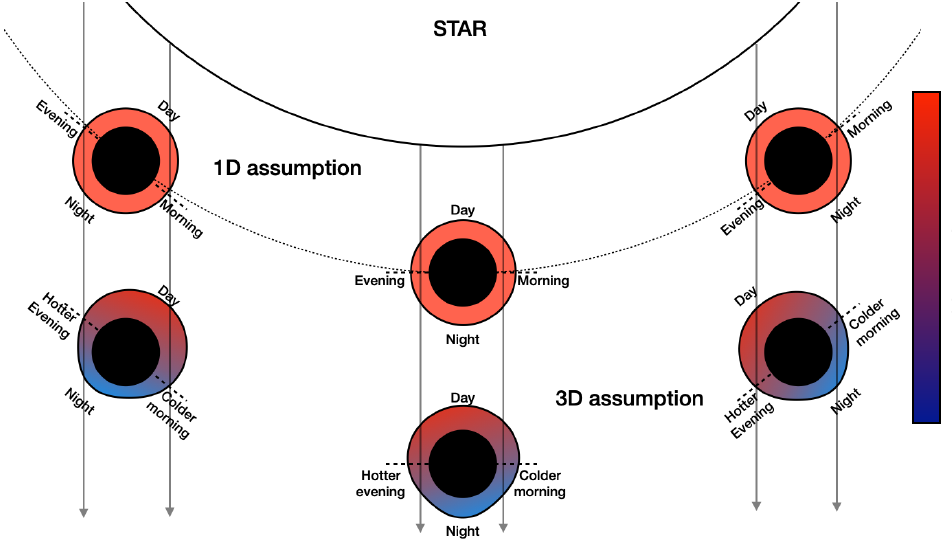
Figure 9. Scheme of the transit at the ingress ( left ), the mid-transit ( middle ) and the egress ( right ) of an ultra-hot Jupiter considering a 1D ( top ) or a 3D ( bottom ) assumption to model its atmosphere. As the planet is tidally locked, we probe a colder region during the ingress than during the mid-transit due to the planet’s rotation. We even probe the shifted hot spot at the egress due to this peculiar geometric configuration. It shows that during the transit, a significant part of the atmosphere is probed, extending significantly above the limbs, as suggested by the 1D